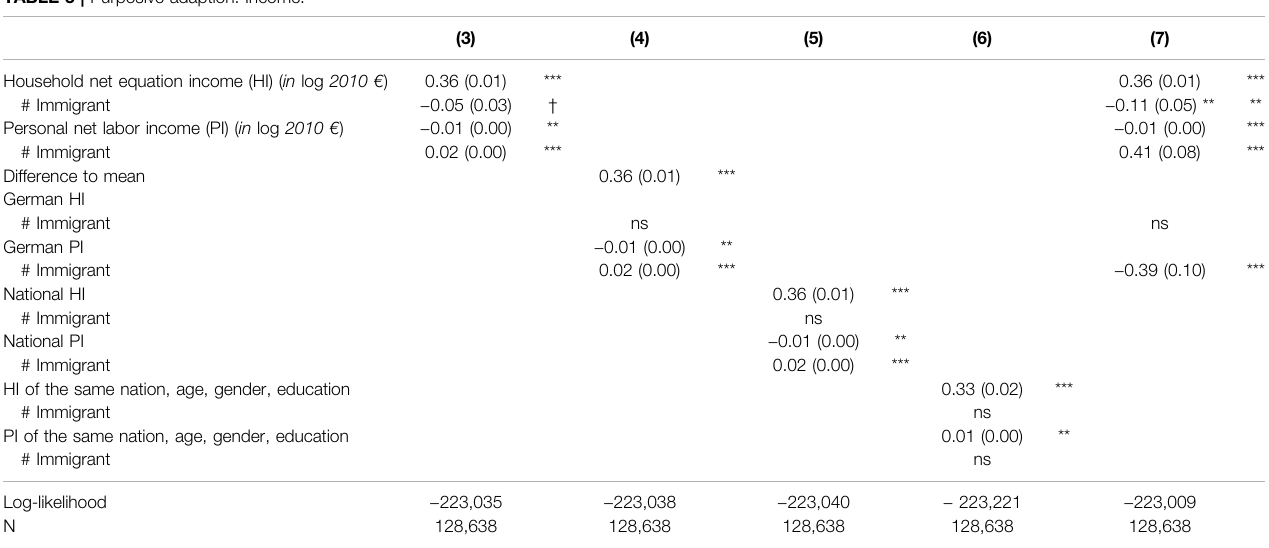
TABLE 3 | Purposive adaption: